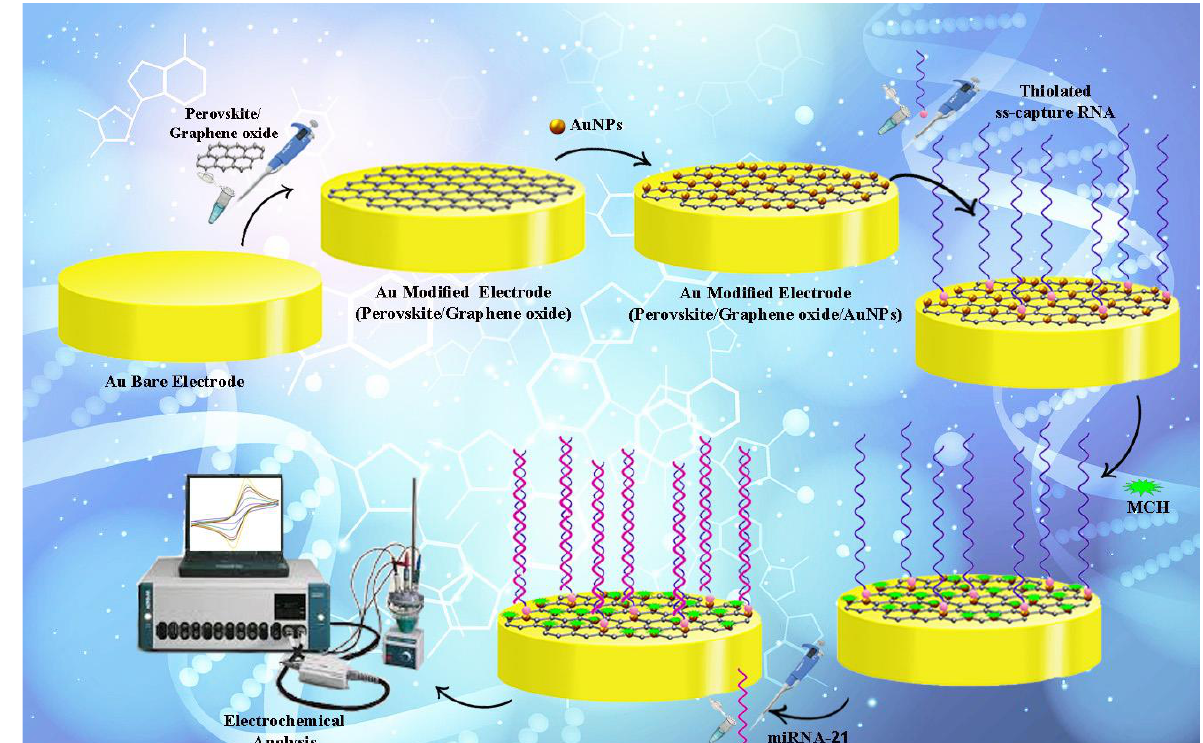
Figure 1. The fabrication process of the electrochemical genosensing platform.